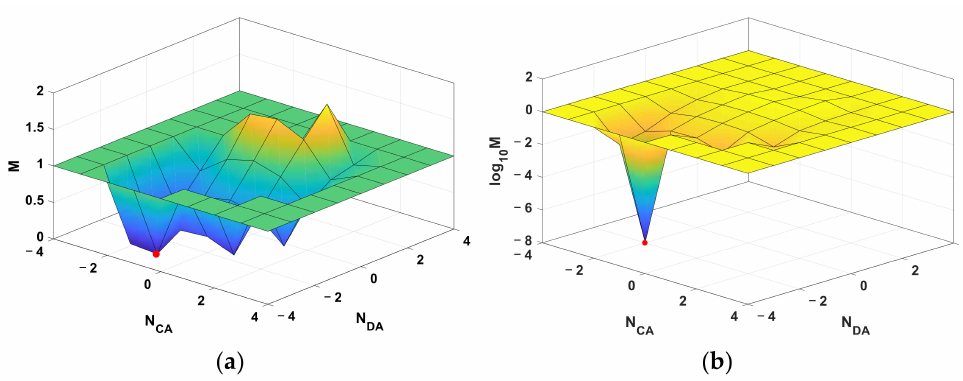
Figure 5. Visualization of cost value projected on N CA , N DA plane. ( a ) Meshed surface of cost value ( M ) . The red point is cost value of target ambiguity M , ( b ) Meshed surface of log 10